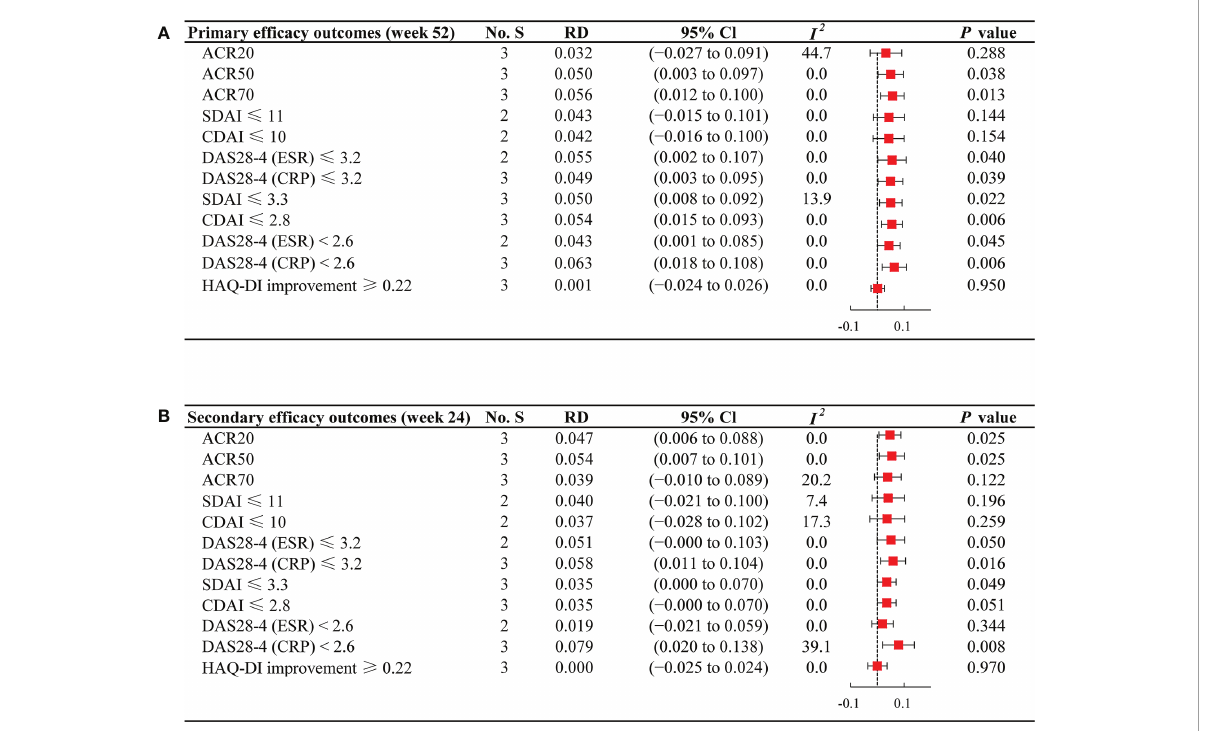
FIGURE 2 Forest plots of ef fi cacy outcomes for JAKi combination therapy versus JAKi monotherapy (A) Forest plots of ef fi cacy outcomes at week 52; (B) Forest plots of ef fi cacy outcomes at week 24; No. S, numbers of studies; RD, risk difference; CI, con fi dence interval; I 2 , heterogeneity; ACR, American College of Rheumatology criteria; SDAI, Simpli fi ed Disease Activity Index; CDAI, Clinical Disease Activity Index; DAS28-4(ESR), Disease Activity Score in 28 joints, erythrocyte sedimentation rate; DAS28-4(CRP), Disease Activity Score in 28 joints, C-reactive protein; HAQ-DI, Health Assessment Questionnaire disability index.